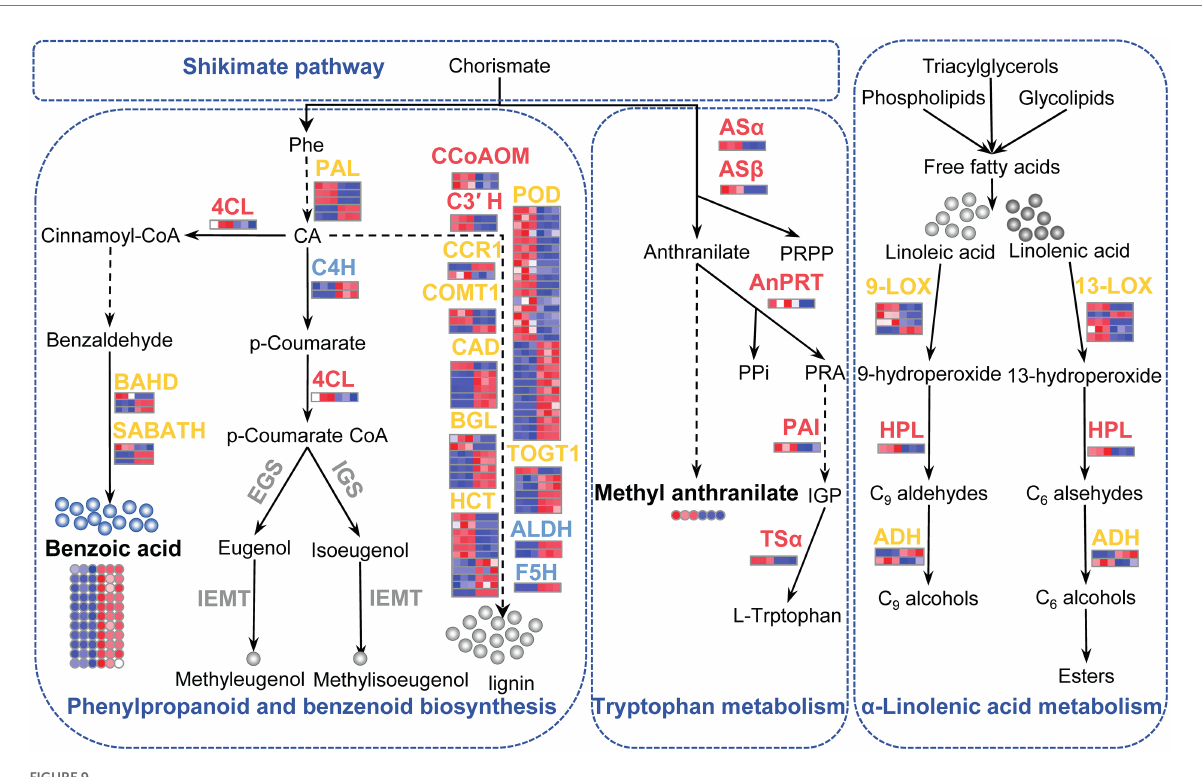
FIGURE 9 Schematic presentation of the biosynthesis of phenylpropanoids, benzenoids, and tryptophan, as well as alpha-linolenic acid metabolism in LJFs of ‘Yujin2’ compared to ‘Fengjin1’. The upregulated, downregulated, mix-regulated, and unchanged genes (bold fonts) and metabolites (small circles) in ‘Yujin2’ are represented in red, blue, yellow, and gray, respectively. The scale bars adjacent to the name of genes o are picked up from the heatmaps for the transcriptome (Figure 4D). The first three and the latter three squares of a bar represent the normalized abundance values of DEGs from ‘Yujin2’ and ‘Fengjin1’, respectively. Red and blue colors reflect high and low expression levels, respectively. The asterisk followed by the gene names indicate that gene expression was validated by qRT-PCR. The solid line and dashed line indicate single-step reactions and multi- step reactions, respectively. 4CL, 4-hydroxycinnamoyl CoA ligase; ADH, alcohol dehydrogenase; ALDH, coniferyl-aldehyde dehydrogenase; AnPRT, anthranilate phosphoribosylanthranilate transferase; AS α , AS β , anthranilate synthase; BGL, beta-glucosidase; C3 ′ H, 5-O-(4-coumaroyl)-D- quinate 3 ′ -monooxygenase; C4H, cinnamate 4-hydroxylase; CA, trans-cinnamate; CAD, cinnamyl alcohol dehydrogenase; CCoAOM, caffeoyl- CoA O-methyltransferase; CCR1, cinnamoyl-CoA reductase; COMT1, caffeic acid 3-O-methyltransferase; EGS, eugenol synthase; F5H, ferulate-5- hydroxylase; HCT, shikimate O-hydroxycinnamoyl transferase; HPL, hydroperoxide lyase; IEMT, isoeugenol O-methyltransferase; IGS, isoeugenol synthase; LOX, lipoxygenase; PAI, phosphoribosylanthranilate isomerase; PAL, phenylalanine ammonia-lyase; Phe, phenylalanine; POD, peroxidase; PPi, inorganic pyrophosphate; PRPP, phosphoribosyl pyrophosphate; SABATH, S-adenosylmethionine-dependent methyltransferase; TOGT1, scopoletin glucosyltransferase; TS α , tryptophan synthase alpha